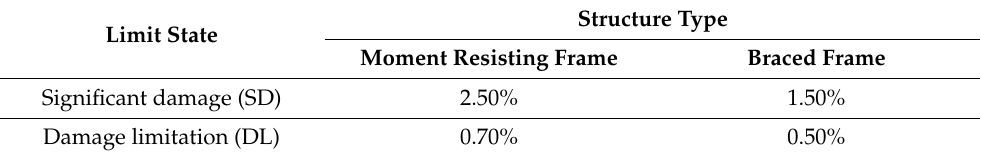
Table 11. Limit values of inter-story drifts.